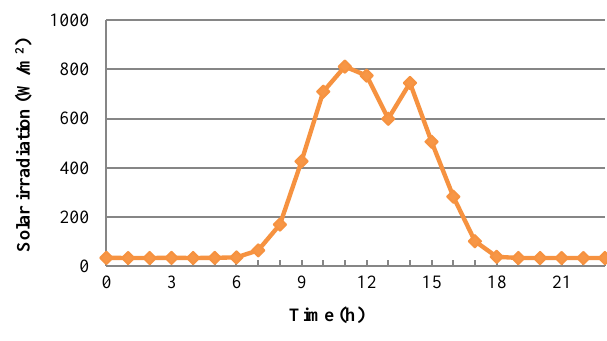
Figure 5. Measured solar irradiation